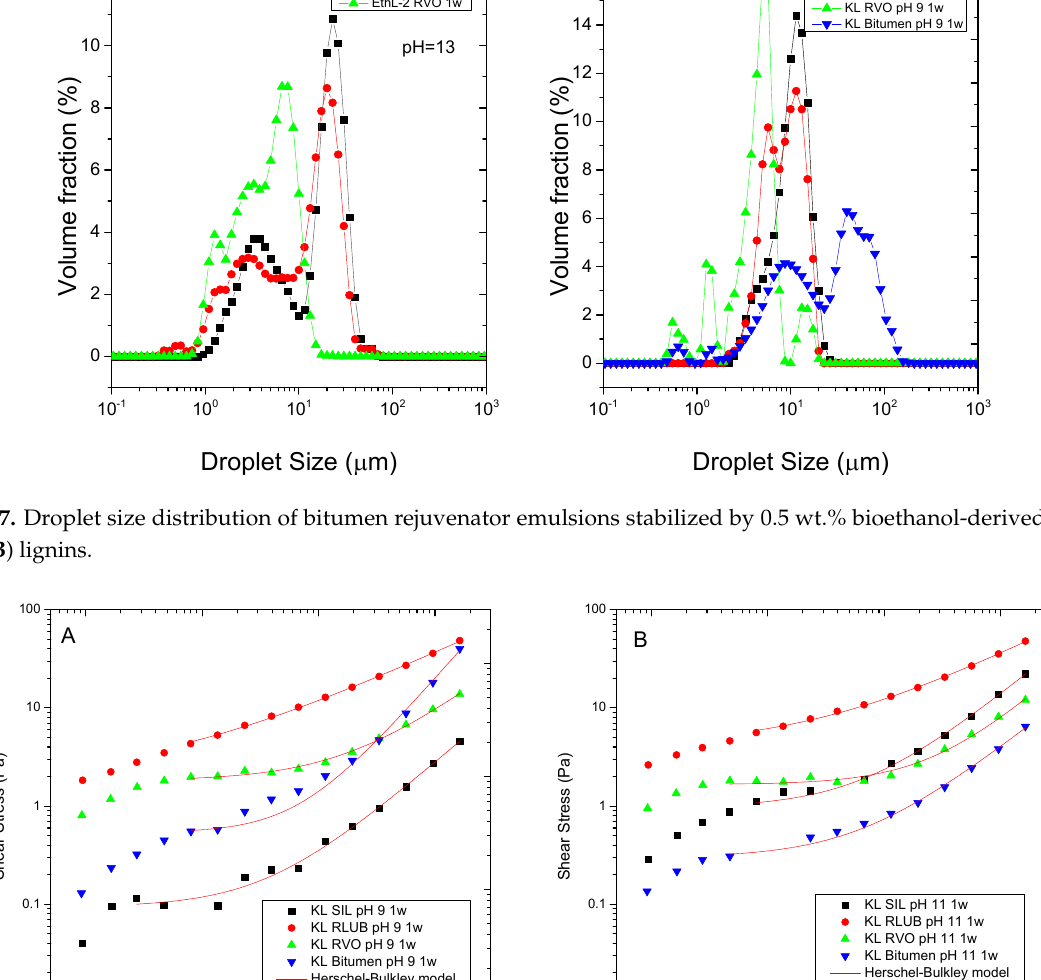
pH Figure 6. Effect of emulsification pH on silicone emulsions flow behaviour ( A ) and yield stress values ( B ) determined from Herschel ‐ Bulkley model All emulsions were formulated with 65 wt.% O, stabilized by 0.5 wt.% Kraft lignin and measured after 1 week storage.